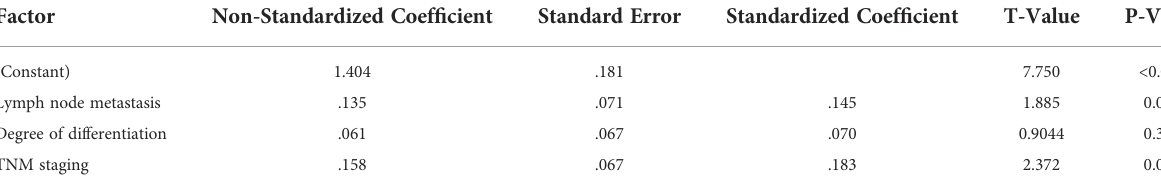
TABLE 4 Multi-factor analysis of the IL-12P7 level in patients with colorectal cancer. Factor